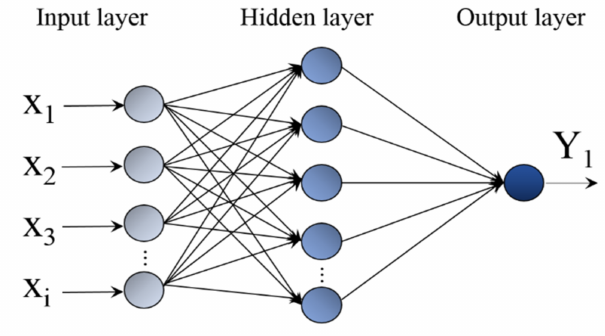
Figure 3. Schematic description of artificial neural network configuration.